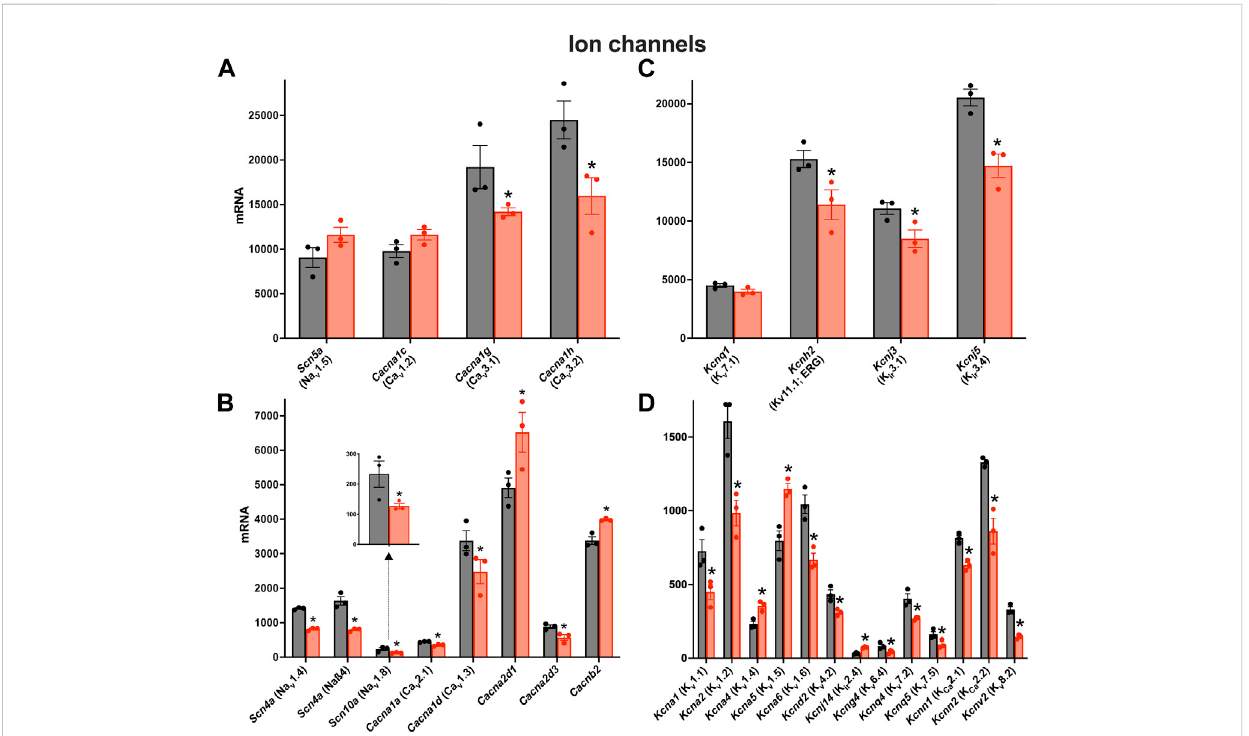
FIGURE 3 Downregulation of many key ion channel transcripts in the AV node in HF. (A – D) , expression of transcripts for Na + and Ca 2+ channels (A and B) and K + channels (CandD) incontrol(blackbars)andHF(redbars).Highlyexpressedionchanneltranscriptsareshownintheupperpanels (AandC) andmore poorlyexpressedionchanneltranscriptsareshowninthelowerpanels (BandD) .Thedatafor Scn10a arealsoshowninazoomedpanel.Genenamesand more common names are shown. Means ± SEM as well as individual data points shown * p <